Question: Does the plotted quantity increase or decrease?
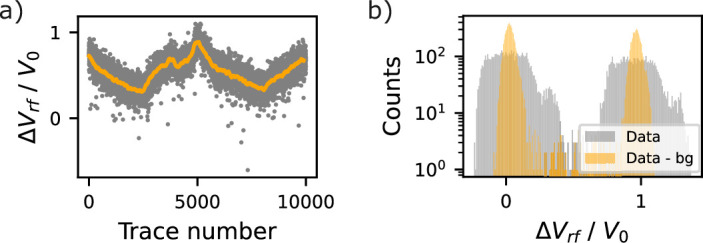
Answer: increasing